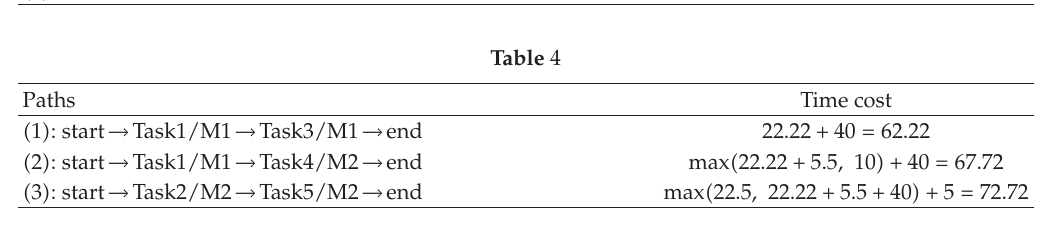
Paths Time cost (cid:3) 1 (cid:4) : start → Task1/M1 → Task3/M1 → end